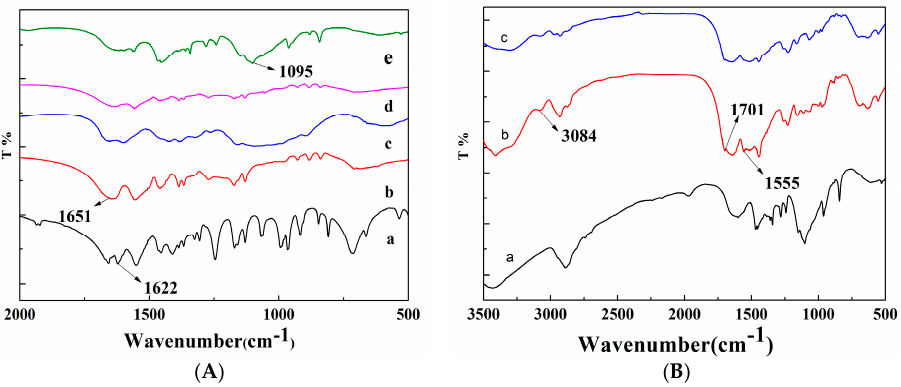
Figure 7. ( A ) The FT-IR spectra (500–2000 cm − 1 ) of (a) NIPAAM powders, (b) PNIPAAm powders,